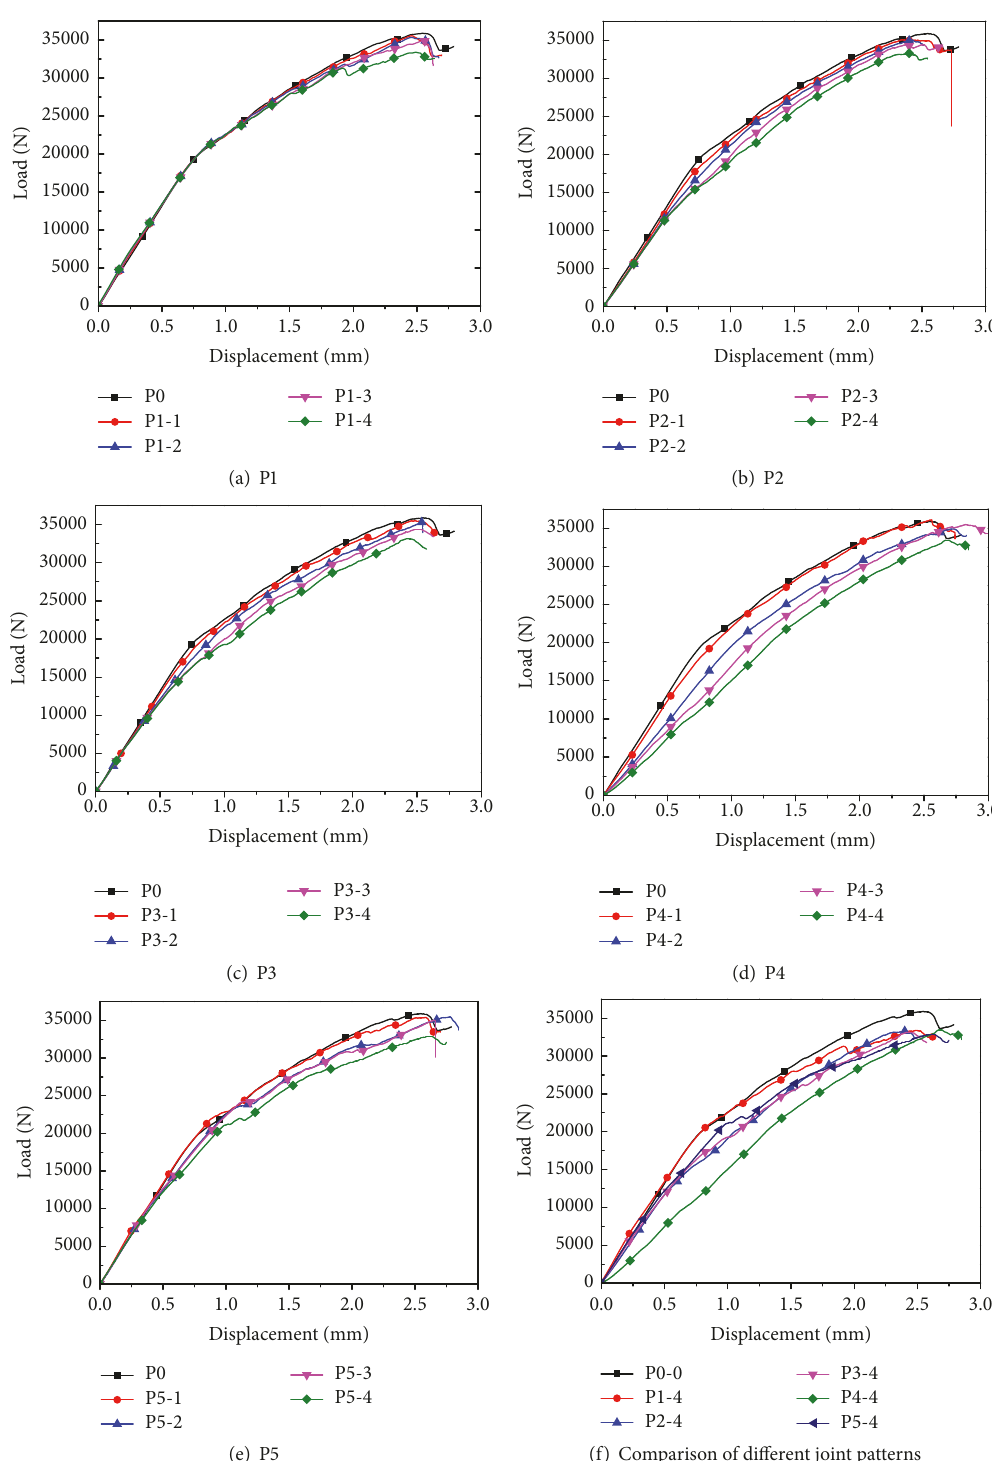
Figure 9: Numerical results of hole perpendicularity error on joint